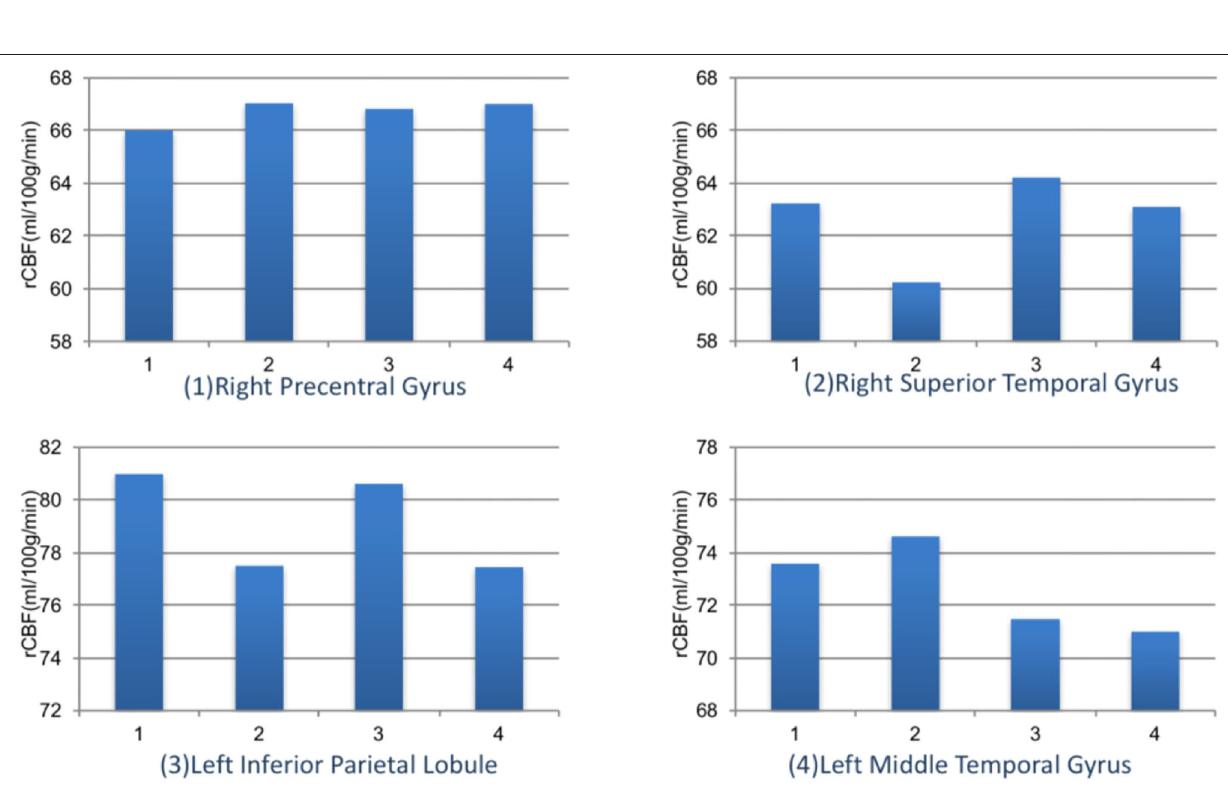
Frontiers in Human Neuroscience |